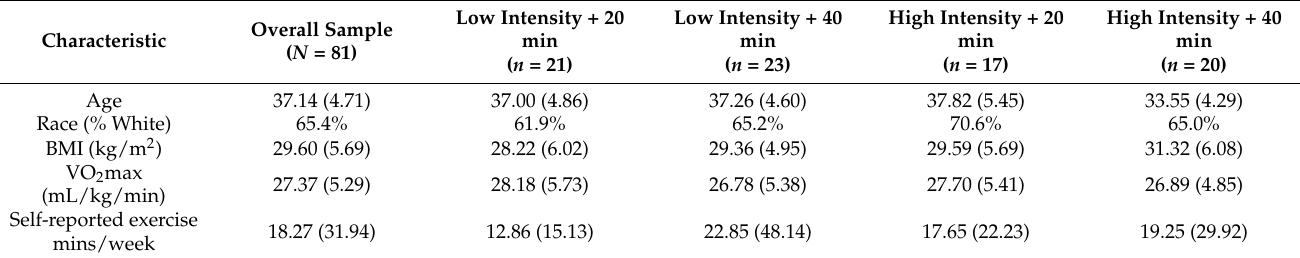
Table 3. Participant baseline